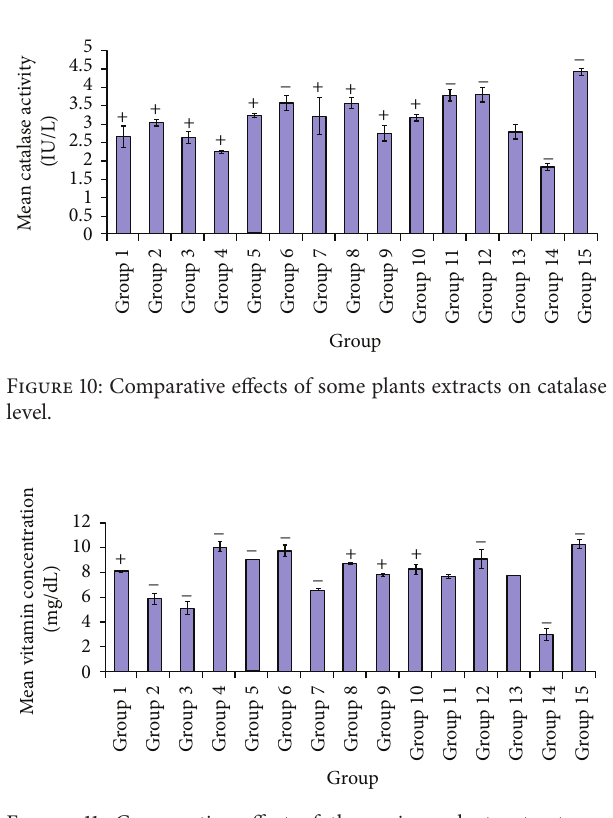
Figure 11: Comparative effect of the various plant extracts on vitamin C levels.